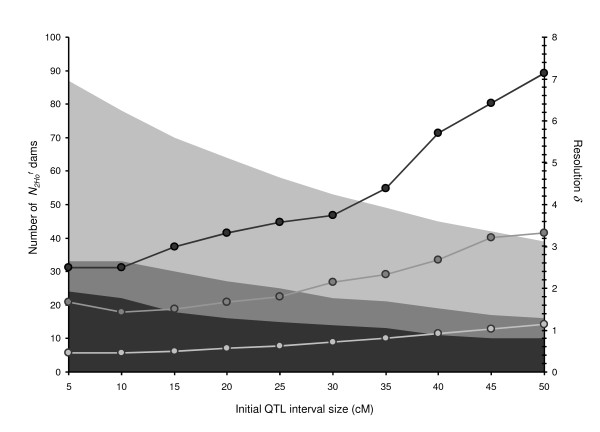
Number of N2Hof dams and resolution δ obtained as a function of the initial interval size θ for three experimental farm capacities. Scenarios corresponding to 35, 50 or 100 places for female's reproduction are respectively indicated in dark, medium and light-grey: area indicates number of homozygote MS/MS N2Hof dams in the G2 generation (left scale); the curves report the resolutions δ obtained (right scale).